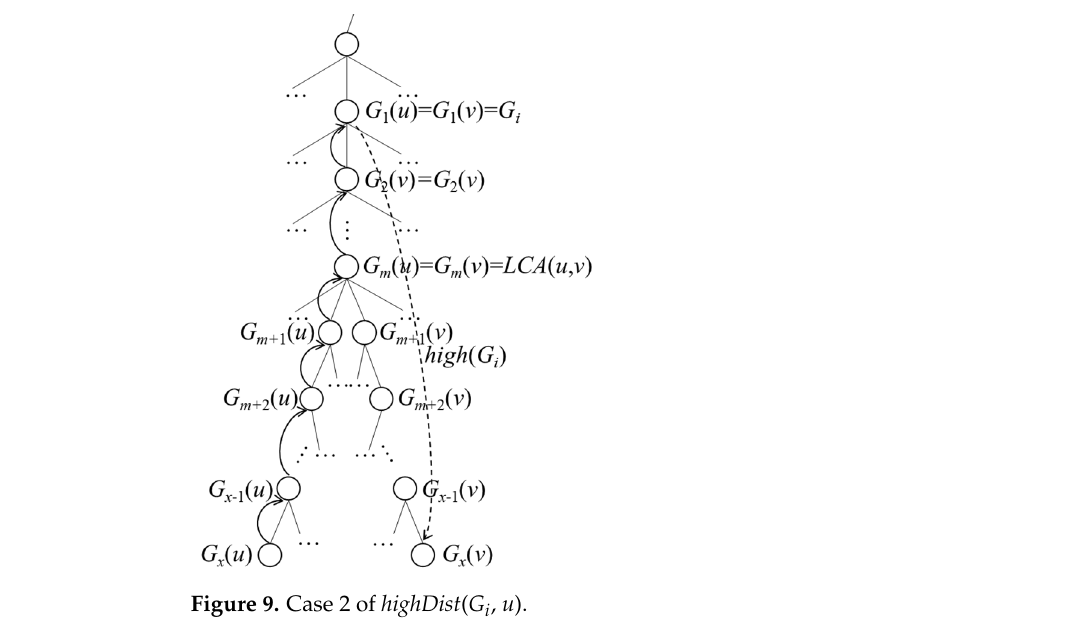
Figure 8. Case 1 of highDist ( G i , u ).